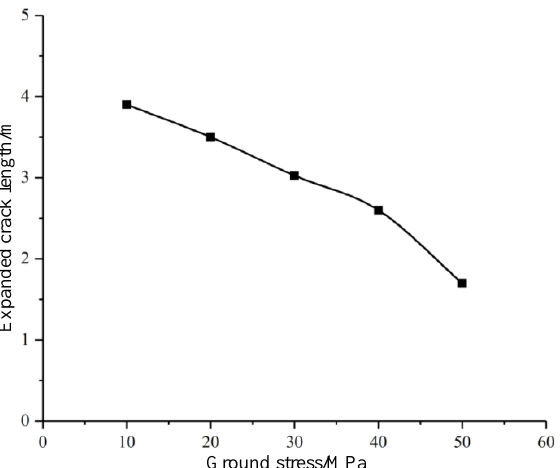
Ground stress/MPa Figure 15. The e ff ect of ground stress on expanded crack length after 200 s of Figure 15. The effect of ground stress on expanded crack length after 200 s of injection.